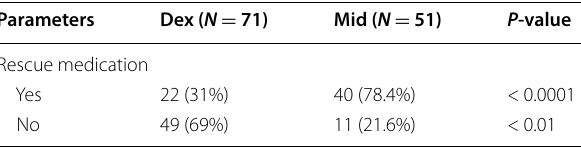
Table 3 Primary endpoint evaluated in the study groups matched with the Mahalanobis distance technique Parameters